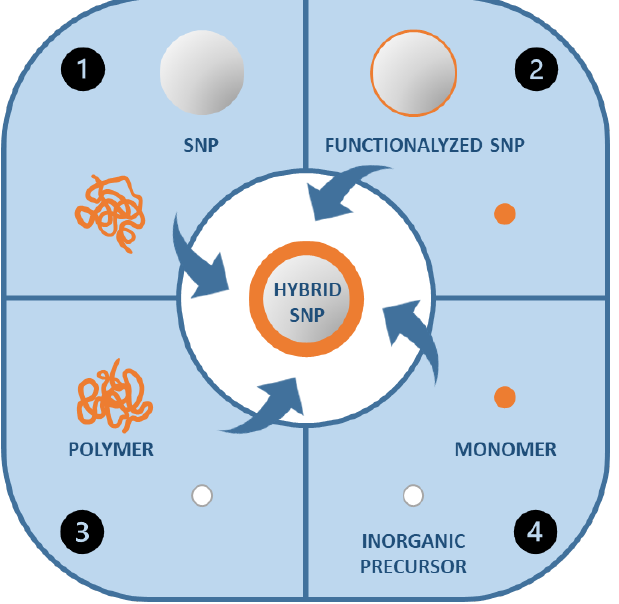
Figure 4. Different synthetic strategies for the formation of polymer-silica hybrid nanoparticles.